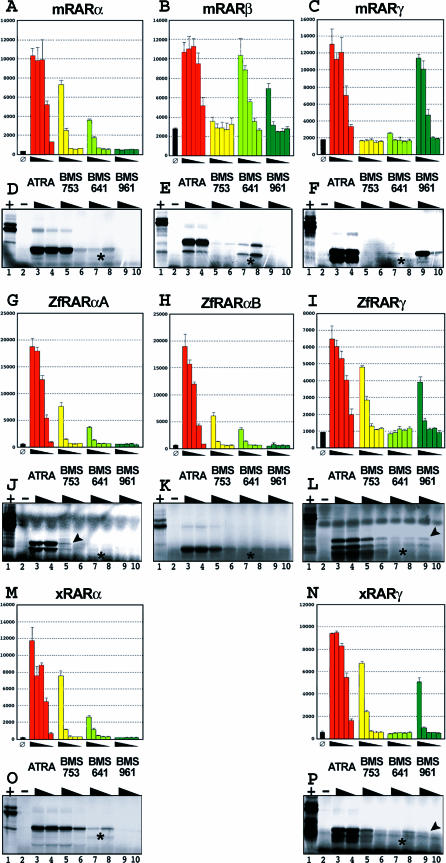
Transcriptional Activity and Binding Selectivity of Vertebrate RARsTranscriptional activity is shown in (A–C), (G–I), (M), and (N), and corresponding binding selectivity in (D–F), (J–L), (O), and (P). Identities of the vertebrate RARs for each activity-selectivity pair are indicated above each bar graph. In each case, a chimera comprising the RAR LBD fused to the GAL4 DNA-binding domain (GAL-RAR(LBD)) has been used. The analysis of transcriptional activity in (A–C), (G–I), (M), and (N) shows transient transactivation assays in Cos1 cells with the indicated GAL-RAR(LBD) expression vector and the cognate (17m)5x-G-luc reporter plasmid, in the presence of increasing concentrations (10−10 to 10−6 M) of ATRA (red bars), BMS753 (yellow bars), BMS641 (light green bars), and BMS961 (dark green bars) respectively. The black bars indicate transactivation in the absence of hormone. Partial proteolysis maps of different in vitro-translated RARs are shown in (D–F), (J–L), (O), and (P). For each proteolysis gel lane 1 represents the undigested protein, lane 2 shows digestion of the receptor in the absence of ligand, lanes 3 and 4 show digestion of the receptor in the presence of ATRA (10−4 to 10−5 M), lanes 5 and 6 show digestion in the presence of BMS753 (10−4 to 10−5 M), lanes 7 and 8 show digestion in the presence of BMS641 (10−4 to 10−5 M), and lanes 9 and 10 show digestion in the presence of BMS961 (10−4 to 10−5 M). Protected bands in the presence of BMS641 are indicated by an asterisk, and slightly protected bands are indicated by arrowheads.